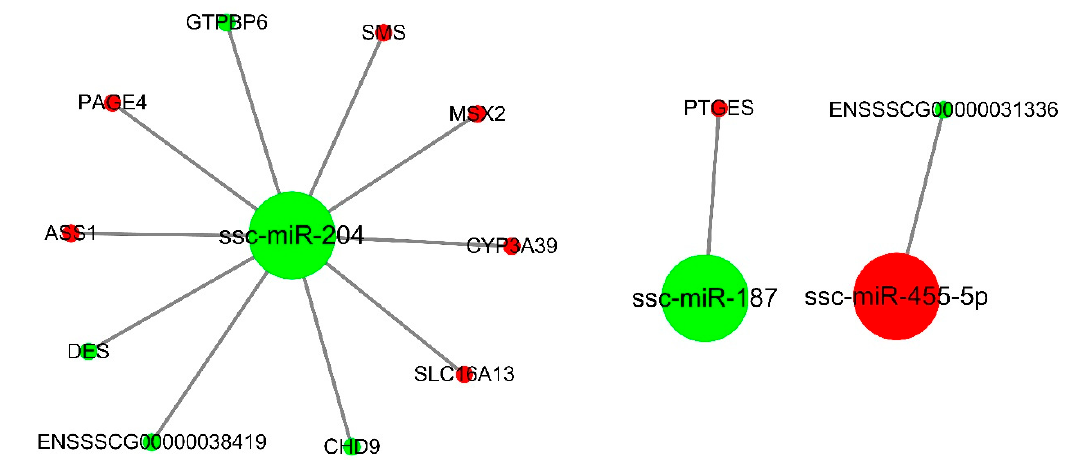
Figure 4. miRNA-gene interaction network (DU49 vs. DU72). Large and small circles represent miRNAs and genes, respectively. Red indicates that the RNA is relatively more abundant, and green indicates that the RNA is relatively less abundant in DU49 than in DU72.